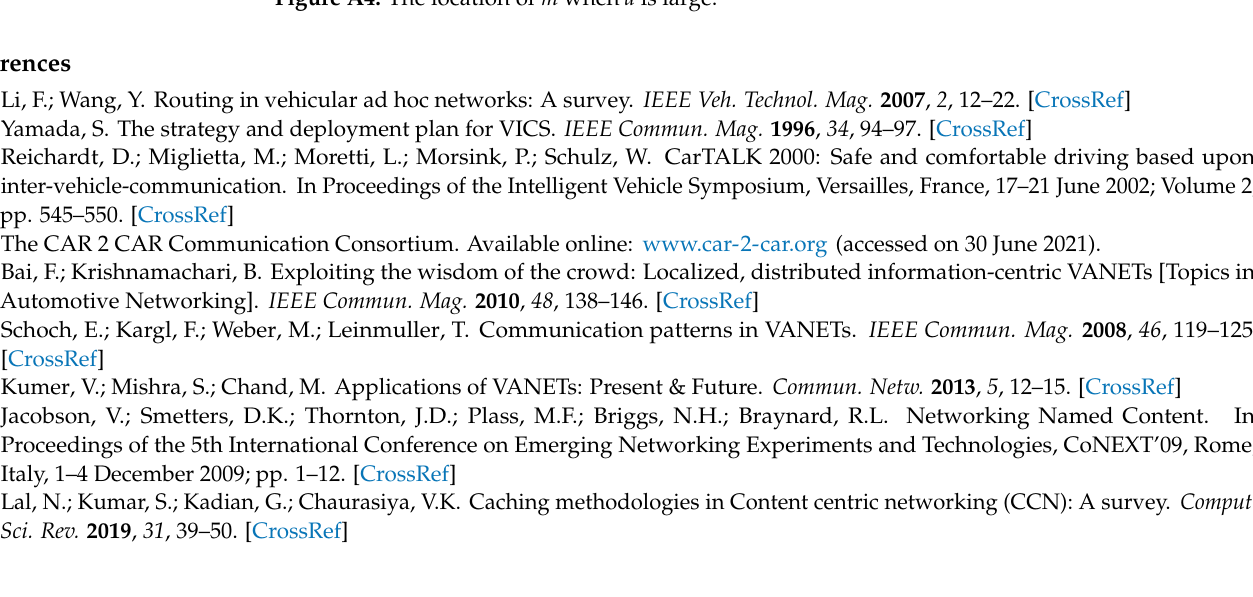
Figure A4. The location of m when a is